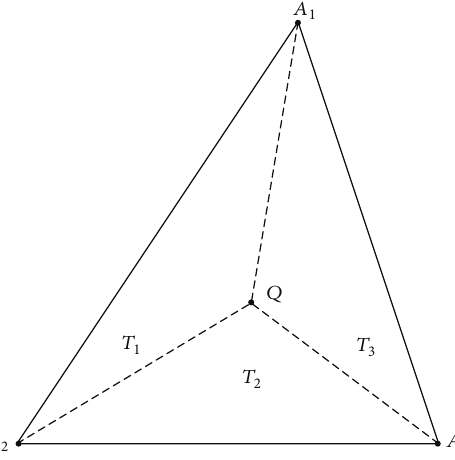
Figure 1: Element 𝑇 ∈ T ∗ ℎ for a triangular